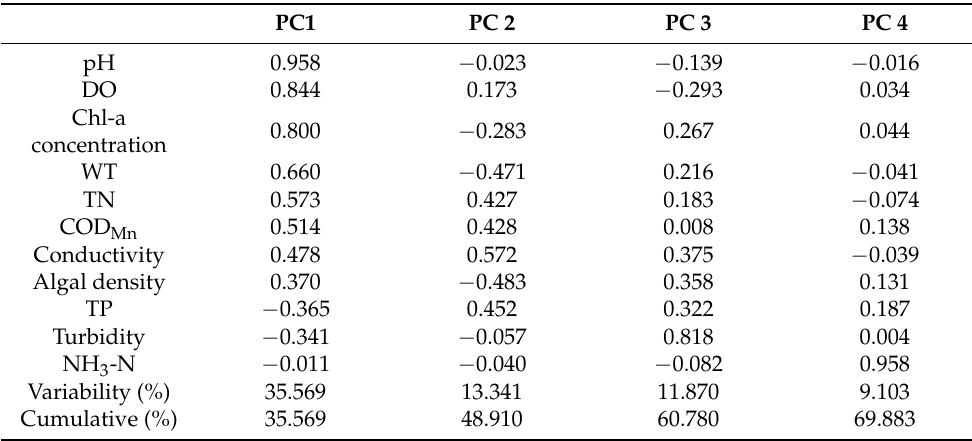
Table 14. The component matrix by SPSS.